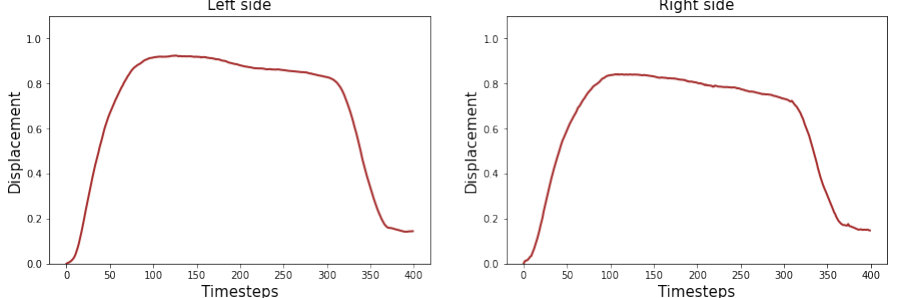
Figure 3. Average of the scaled displacement for the commissure markers.